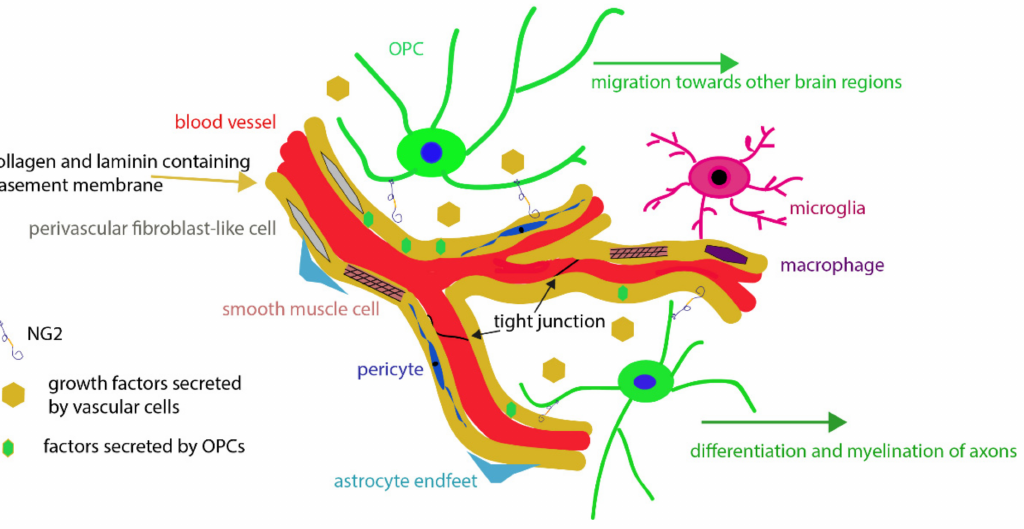
Figure 4. OPCs at the NVU. Schematic showing possible mechanisms of OPC interactions with blood vessels and the different cell types localized at the NVU that OPCs can possibly encounter in this